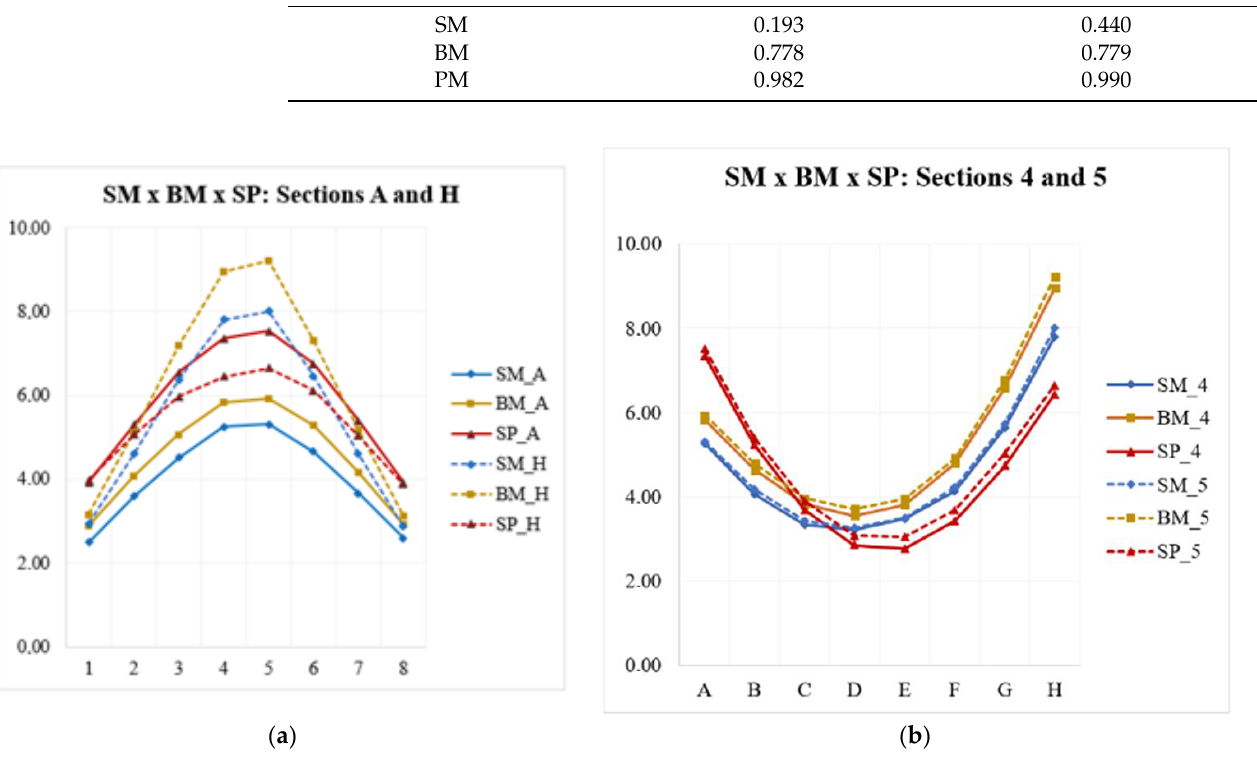
Figure 11. ( a ) SM × BM × SP scatter plot—Sections A and H; ( b ) SM × BM × SP scatter plot—Sections 4 and 5.